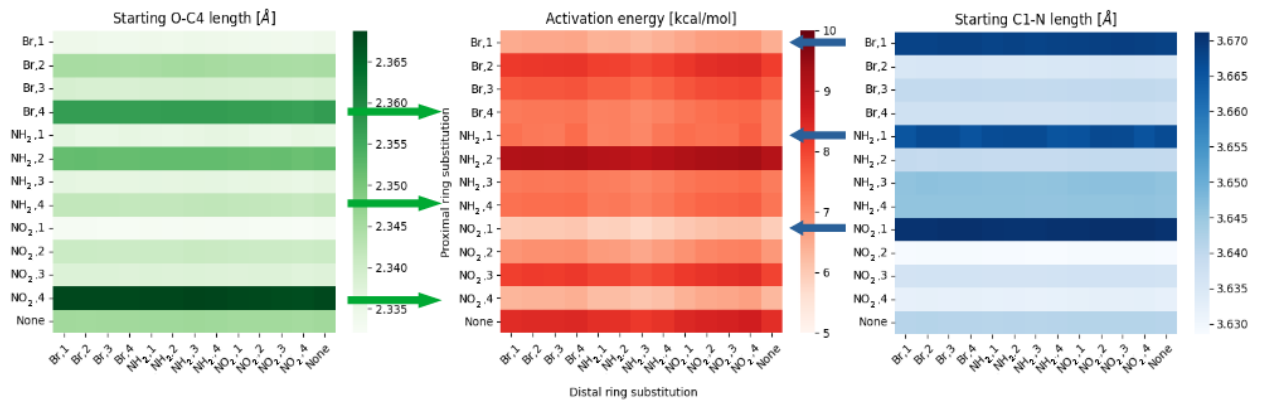
Figure 6. Heatmaps of the activation energy ( middle ), O—C4 distance ( left ) and N—C1 distance ( right ) for different substitution patterns within meta compounds